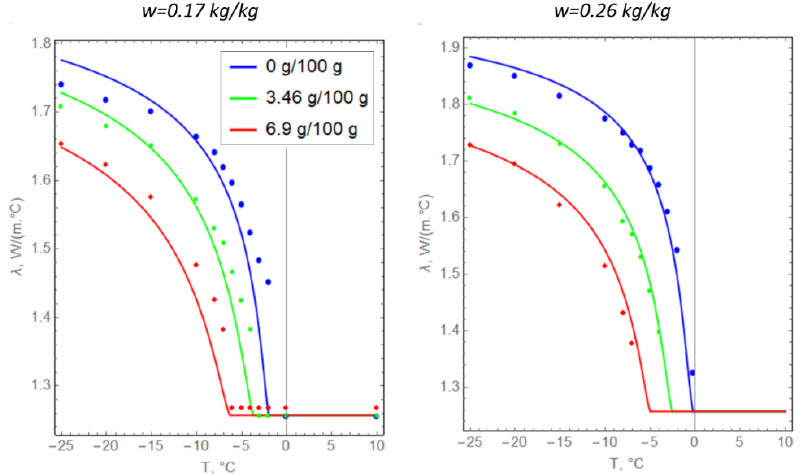
Figure 4. Temperature dependences of the specific heat capacity of argillite-like clay.